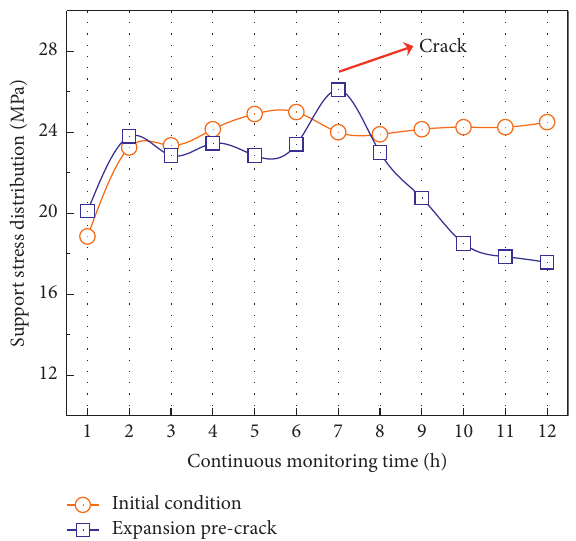
Figure 16: Distribution curve of support